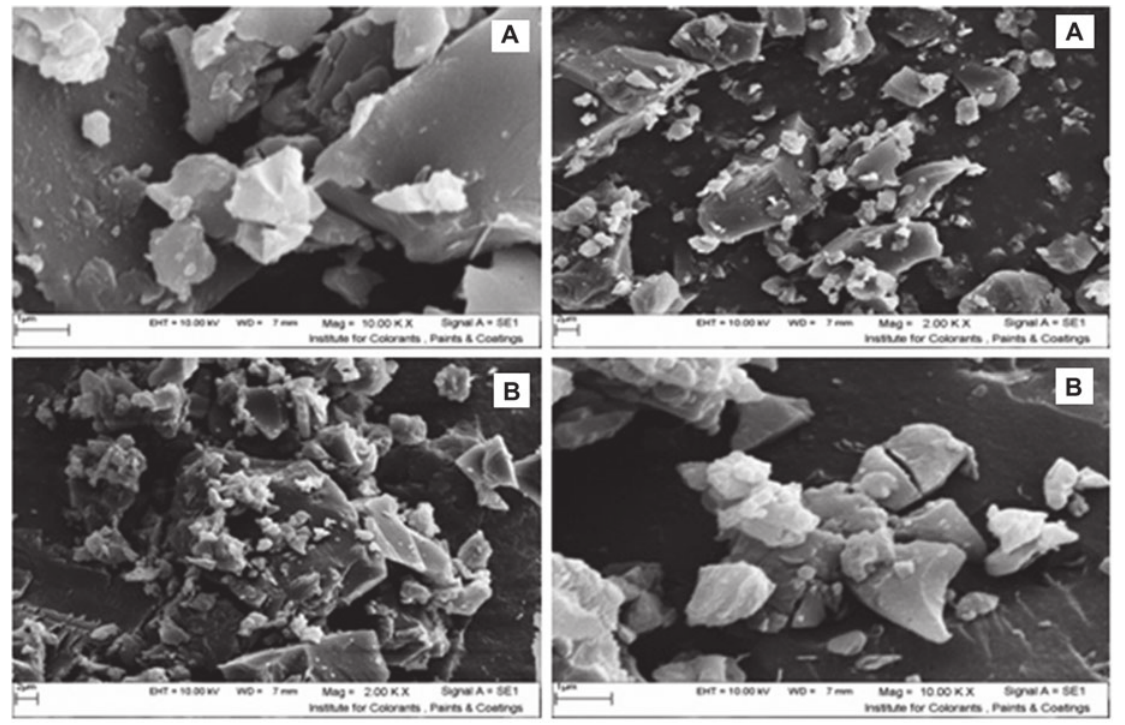
Figure 3 Scanning electron micrographs of PA-nanocomposite fi lms 3a (A) and 3b (B).